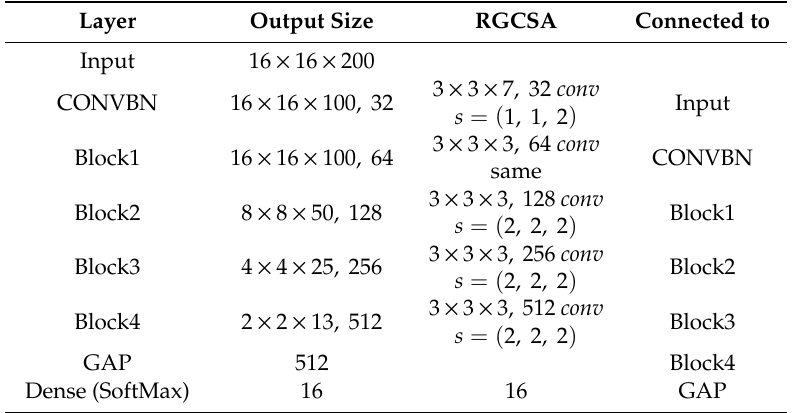
Table 1. The network configuration of the proposed RGCSA